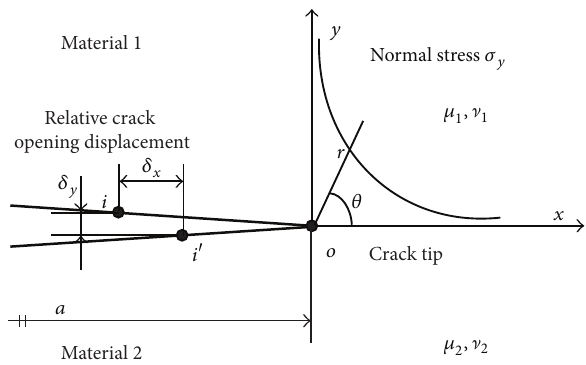
Figure 1: Stress distribution and relative crack displacement of an interface